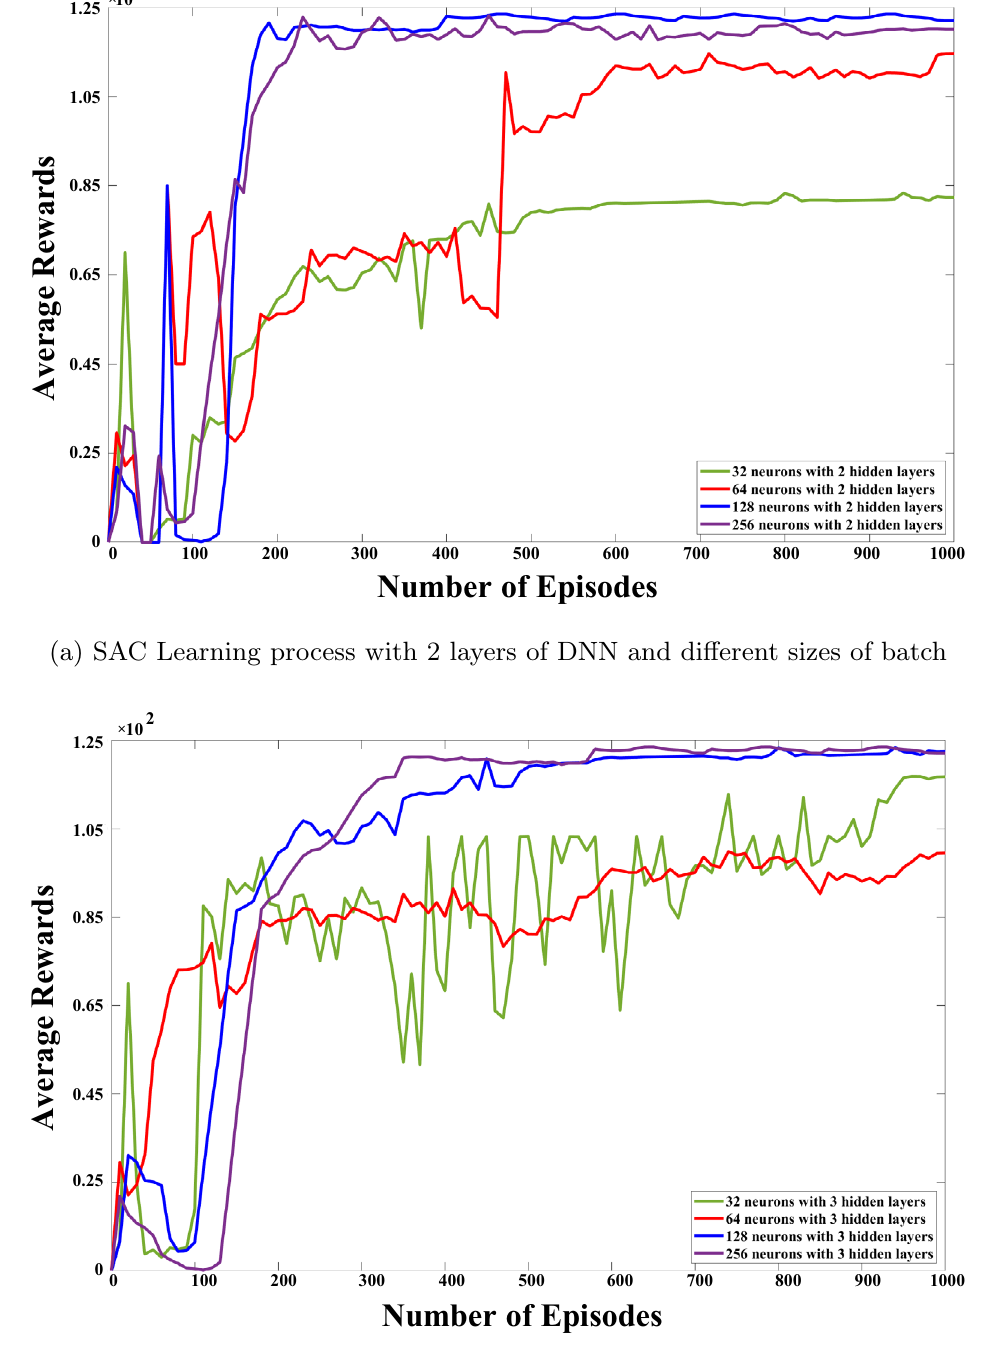
Figure 5. SAC hyperparameters